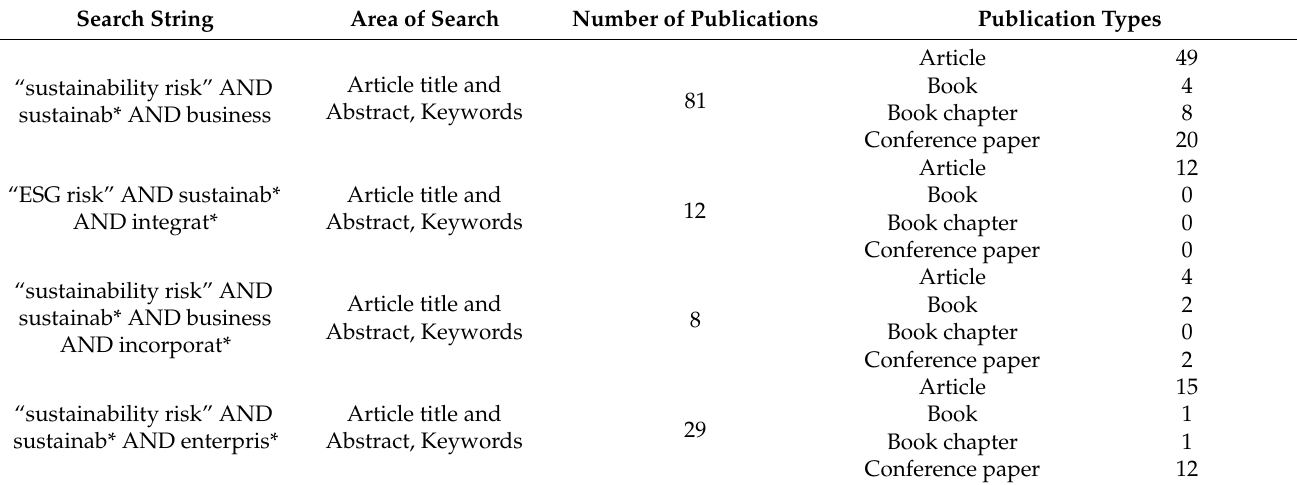
Table 2. Numbers and types of documents under examination.